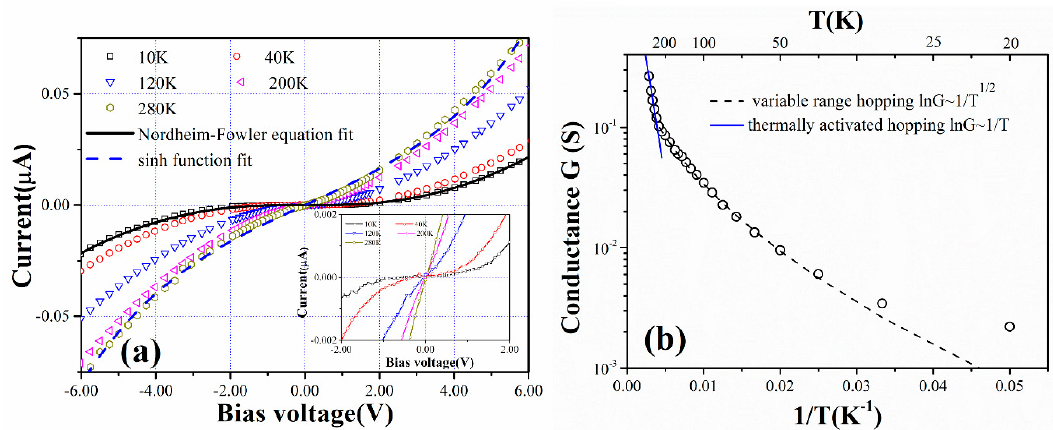
Figure 7. ( a ) The I-V curves of the 62% coverage Pd NP film measured at different temperatures. The solid curve and dashed curve fit the experimental data with a Nordheim-Fowler equation and sinh function, respectively. The inset shows a magnified view to illustrate the blockade characteristics at cryogenic temperatures. ( b ) Temperature dependences of the zero bias conductance. The solid curve and dashed curve fit the experimental data with lnG ~ 1 / T scaling and lnG ~ 1 / T 1 / 2 scaling,